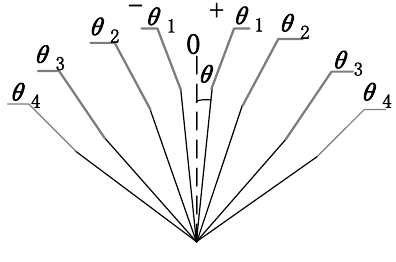
Figure 5. Input angle signal of steering wheel.